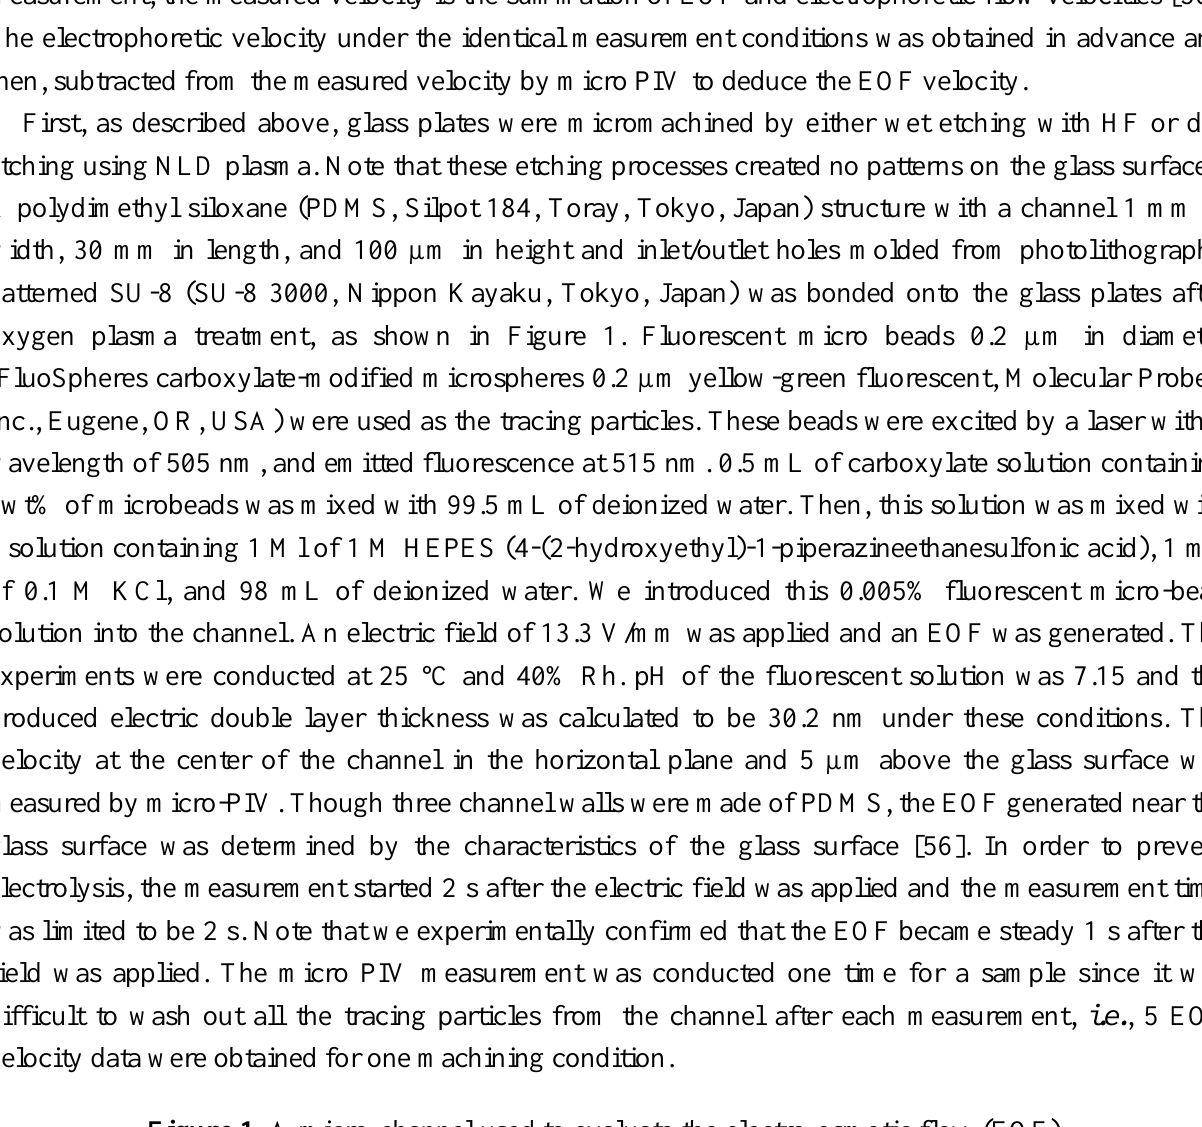
Figure 1. A micro-channel used to evaluate the electro-osmotic flow